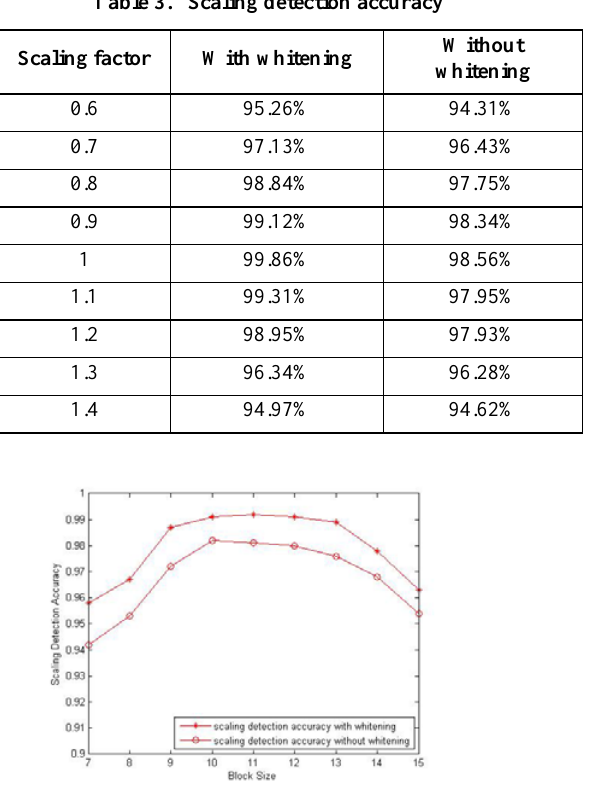
Figure 3. Scaling detection accuracy versus block size Table 4. PSNR (dB) comparison